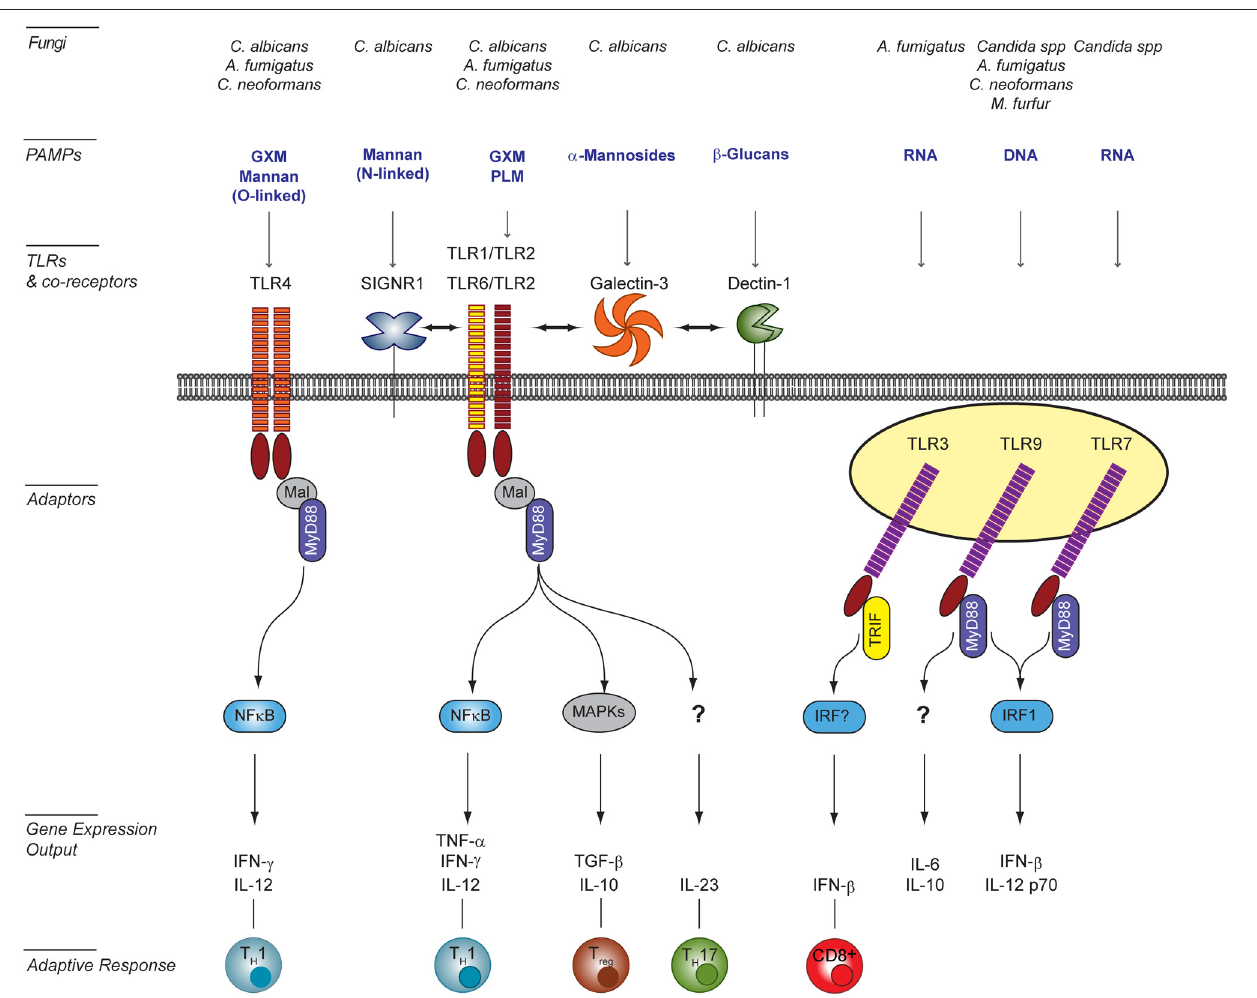
FIGURE 1 | TLR signaling induced in host cells upon interaction with fungal pathogens. Surface Toll-like receptors (TLRs), as well as endosomal TLRs participate to the recognition of fungal PAMPs [e.g., O- and N-linked mannans, phospholipo-mannan (PLM), glucuronoxylomannan (GXM), α -mannosides, β -glucans, DNA, and RNA]. Activation of surface TLRs involves their homo- (TLR4) or hetero-dimerisation (TLR2/TLR1 or TLR6). The diversity of signaling pathways is increased by the involvement of co-receptors of the C-type lectin family (e.g., SIGNR1 and Dectin-1) or Galectin-3. Confirmed physical interactions between PRRs are represented by double-head arrows. The integration of simultaneously